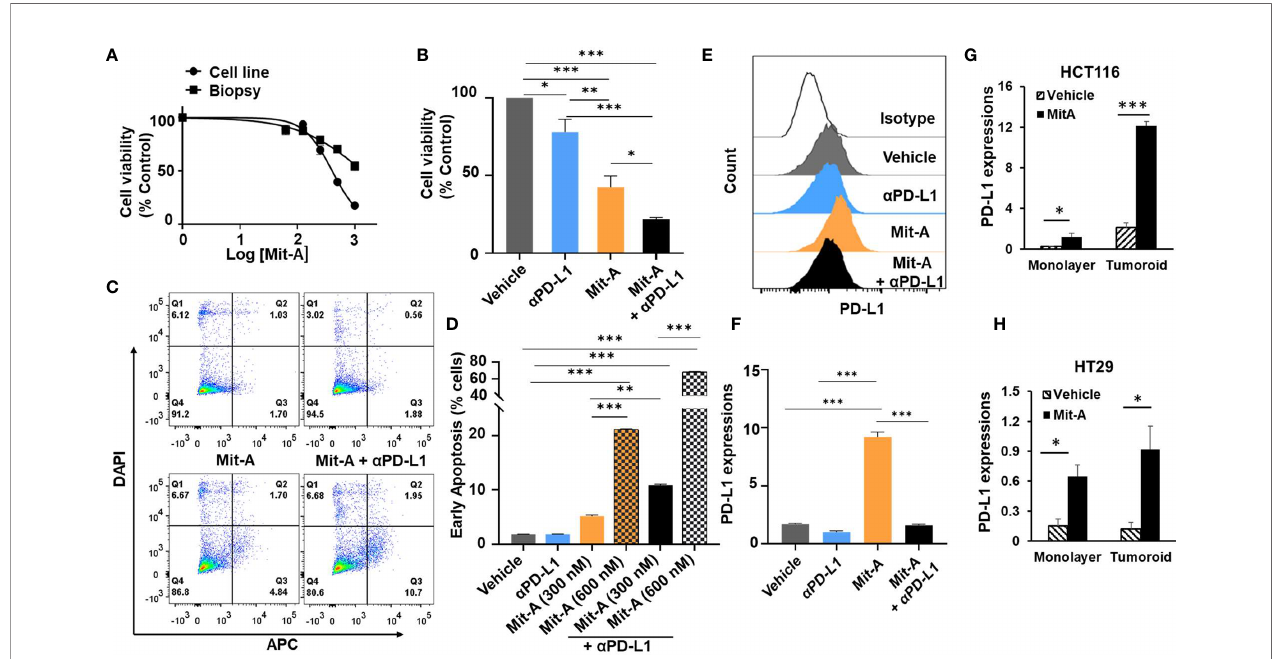
FIGURE 1 | Mit-A combined with CB causes increased early apoptosis by sensitizing the orthotopic tumor via increased PD-L1 expression. (A) Cell viability assay for monolayer cultures of MC38 cell line or biopsies from orthotopic tumors by CellTiter-Glo (Promega) post 48 h of Mit-A treatment. (B) Cell viability of MC38 tumoroids of orthotopic biopsies grown on scaffold. On Day 4 tumoroids were treated with Mit-A (250 nM) with or without a PD-L1 mAb (10 µg/ml) and Cell Titer Glo assay was performed 48 h post treatment. (C , D) Annexin V-binding assay of monolayer culture of MC38 tumor biopsies treated with vehicle, Mit-A with or without anti-PD-L1 ( a PD-L1) mAb (20 µg/ml) (post 72 h of treatment) where (C) depicts the representative images of Annexin-V binding assay; (D) represents the percentage of cells from the Annexin V-binding assay undergoing early apoptosis (Q3). (E, F) Mit-A treatment sensitizes the MC38 biopsy leading to the increased expression of PD-L1 which was reversed upon addition of the a PD-L1 mAb treatment where (E) depicts the histogram from the fl ow analysis and (F) represents the bar graph plot of PD-L1 expression of MC38 biopsy monolayer cells treated with Mit-A (300 nM) and a PD-L1 mAb (20 µg/ml). (G, H) represent the PD-L1 expressions for HCT116 and HT29 cells grown as monolayer and tumoroids upon treatment with Mit-A (10 and 50 nM for HCT 116 and HT29 monolayer) and (25 and 100 nM for HCT116 and HT29 tumoroids), respectively. IC50 values were analyzed by non-linear regression analysis in Graphpad prism (version 8). Data analyzed as mean ± SEM by One-way ANOVA (Fischer ’ s LSD test); *p < 0.05, **p < 0.01, ***p < 0.001. A representative of two experiments is